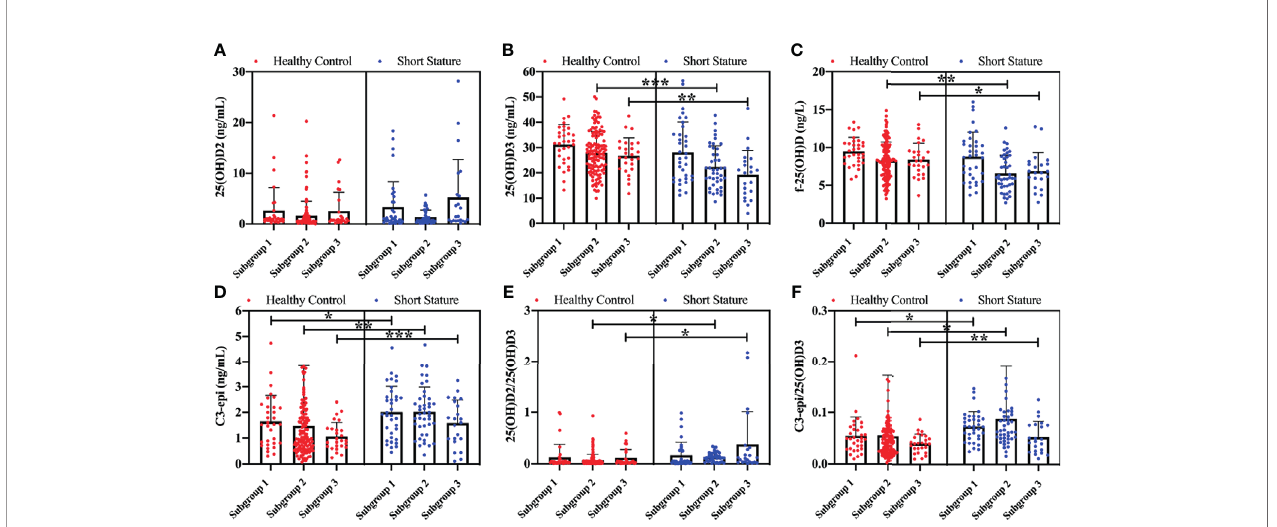
FIGURE 1 | Comparison of various vitamin D components between short stature and healthy control subgroups. Levels of 25(OH)D2 (A) , 25(OH)D3 (B) , f-25(OH)D (C) , and C3-epi (D) , and ratios of 25(OH)D2/25(OH)D3 (E) and C3-epi/25(OH)D3 (F) for all subgroups. *P < 0.05, **P < 0.01, and ***P < 0.001 were considered statistically signi fi cant. 1) Subgroup 1 (preschool age): 1~6 years old; 2) Subgroup 2 (school age): 7~12 years old; and 3) Subgroup 3 (adolescence): 13~18 years